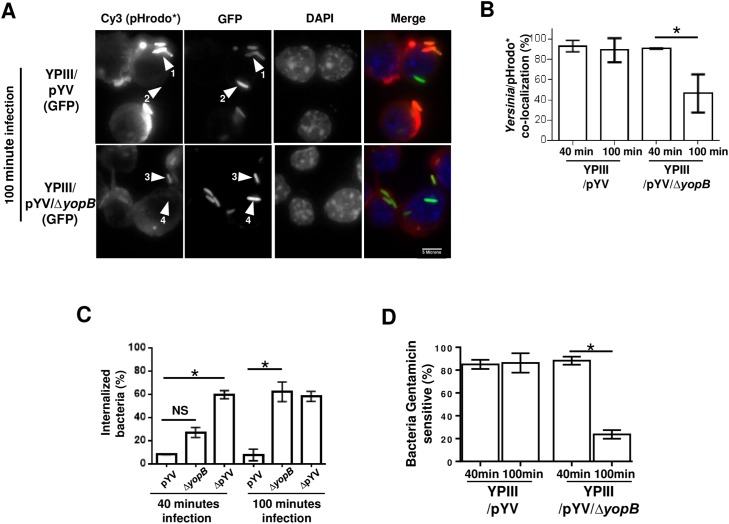
Secretion of type III effectors is sufficient to create but not maintain YACs.(A) Peritoneal macrophages were infected with GFP-expressing wild-type (YPIII/pYV) or a type III translocation mutant (YPIII/pYV/ΔyopB) strain for 60 minutes prior to the addition of pHrodo and incubated for an additional 40 minutes of infection (= 100 mins total infection). See main text for explanation of the indicated arrows. (B) The percentage of the bacteria co-localizing with the pHrodo signal from 40 or 100 mins of infection are shown from counting >30 macrophages from a single representative experiment that was repeated multiple times. (C) Peritoneal macrophages were infected with the indicated strains for either 40 or 100 minutes and then stained with a membrane marker (CD11b) and analyzed by fluorescent microscopy. Individual bacteria were scored for being membrane bound or internalized by examining each individual Z-plane image and the percentage of internalized was plotted. The data shown is representative of multiple experiments done with similar results in which >40 macrophages in each experiment were analyzed. (D) Peritoneal macrophages were infected with the indicated strains for either 40 or 100 minutes. Prior to each sample point, gentamicin was added to some of the wells to kill extracellular (and/or surface-exposed) bacteria. The percentage of gentamicin sensitive bacteria was derived by comparing the number of colony forming units (CFU) recovered from three independent wells per condition. Shown is a representative data set of a single experiment repeated several times with similar outcomes. (* P < 0.05 using student t-test)